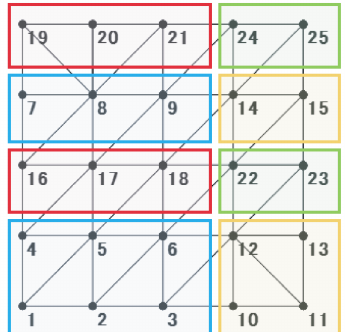
Figure 2. Block multi-color ordering for a two-dimensional triangular mesh.